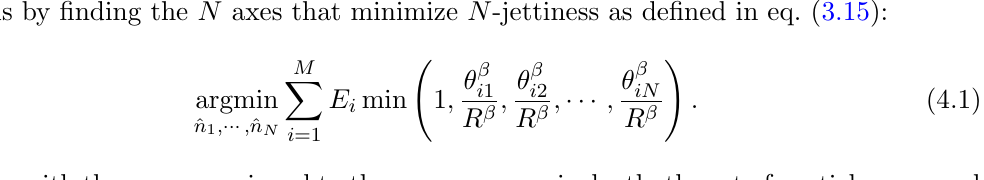
Figure 7 . An illustration of jet clustering algorithms as projections to N -particle manifolds in the space of events. (a) Exclusive cone (cid:12)nding algorithms yield N jets as the closest N -particle approximation to the event, as measured by the EMD. (b) Sequential recombination algorithms iteratively (cid:12)nd the best ( M 1)-particle approximation to the M -particle event, either (dashed) (cid:0) merging two particles or (solid) removing a particle and calling it a